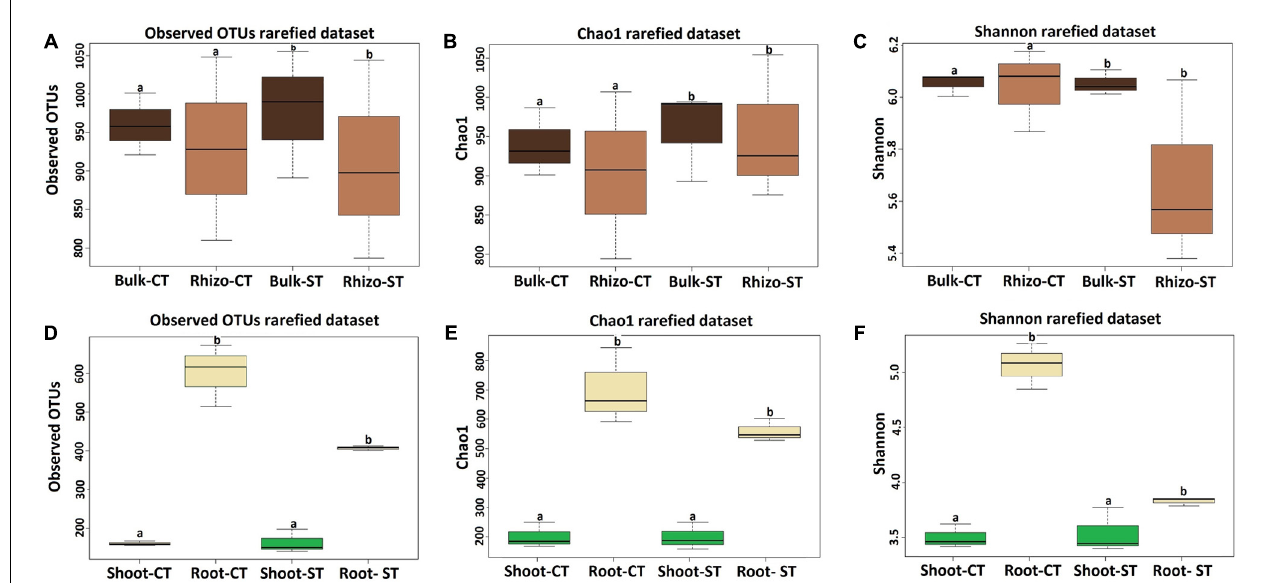
FIGURE 2 | Variation patterns of alpha diversities of the bacterial communities associated with bulk soil, rhizosphere, root and shoot under two tillage practices; CT and ST. The alpha diversity estimates; Total number of observed OTUs, Chao1 estimator and Shannon’s diversity of soil samples (bulk soil and rhizosphere) are displayed in (A–C) respectively, and of plant samples (root and shoot) are displayed in (D–F) respectively. Sequencing reads of soil samples and plant samples were rarefied at an even sequencing depth 6,191 and 9,765 reads/sample respectively prior the analysis. Lowercase letters denote statistically significant differences